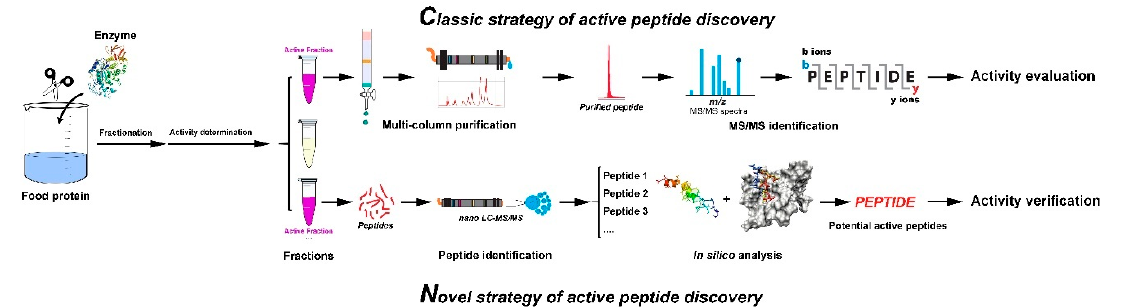
Figure 1. Workflow of active peptides discovery. Those “Active Fractions” in purple color were further used for active peptides purification and